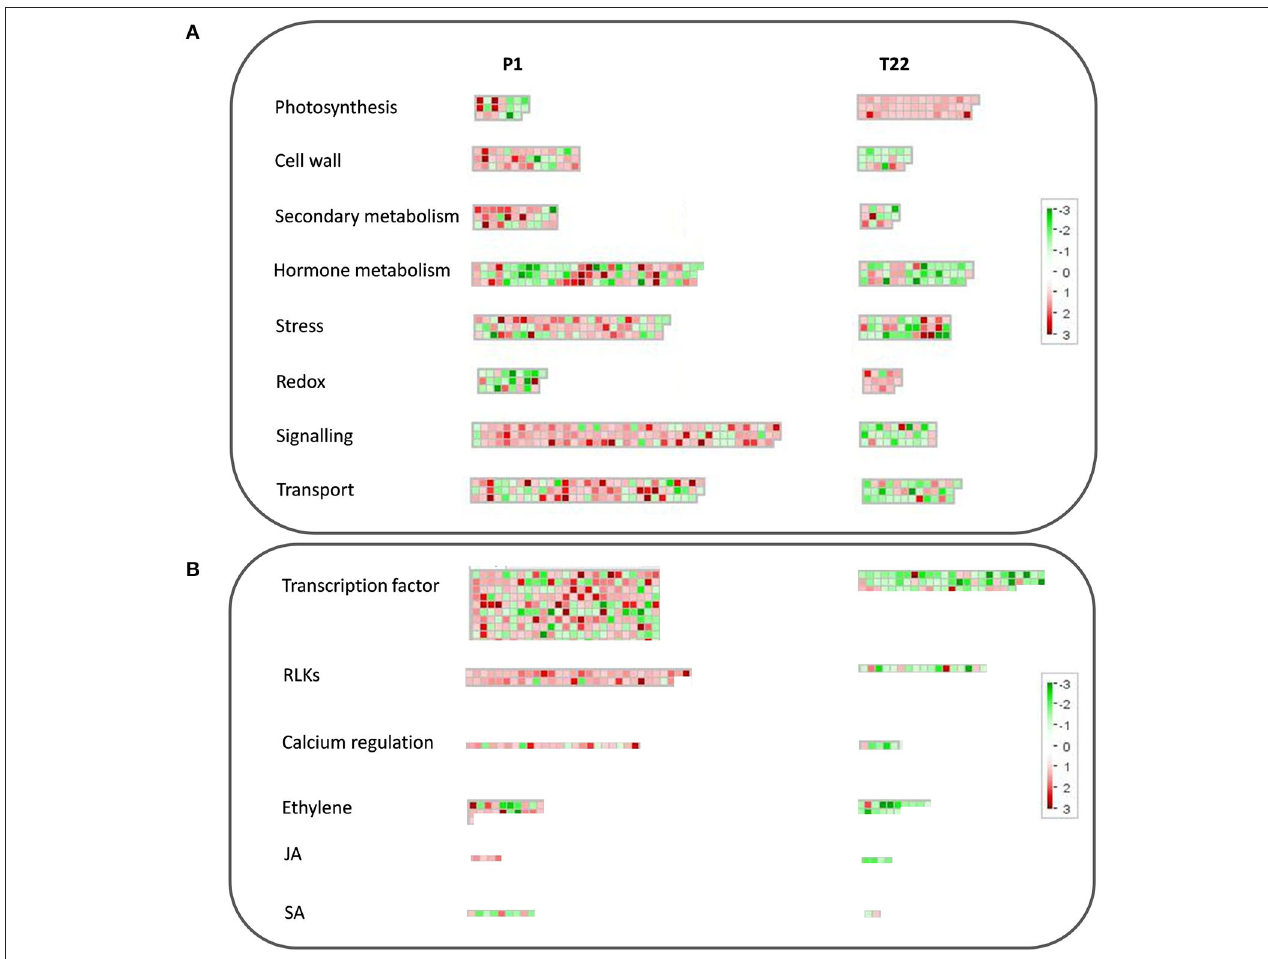
FIGURE 10 | MapMan analysis of tomato transcriptomic profiles imposed by T. atroviride P1 or T. afroharzianum T22 inocula at 20 ◦ C. Organization of tomato by differentially expressed genes (DEGs) in functional categories according to the MapMan ontology across the interaction with spores of P1 or T22. (A) Overview of functional categories related to the main cellular processes ; (B) Overview of the most relevant defense-related regulation processes. Each box represents a transcript; red color indicates upregulation, while green indicates downregulation. Boxes are grouped based on the ontological